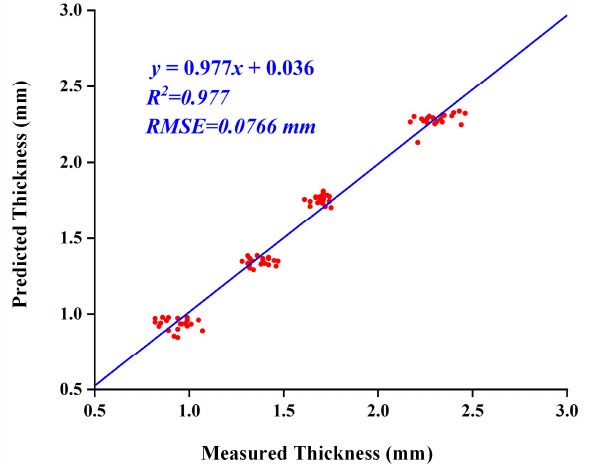
Figure 15. Comparison results of measured and predicted chip thickness.